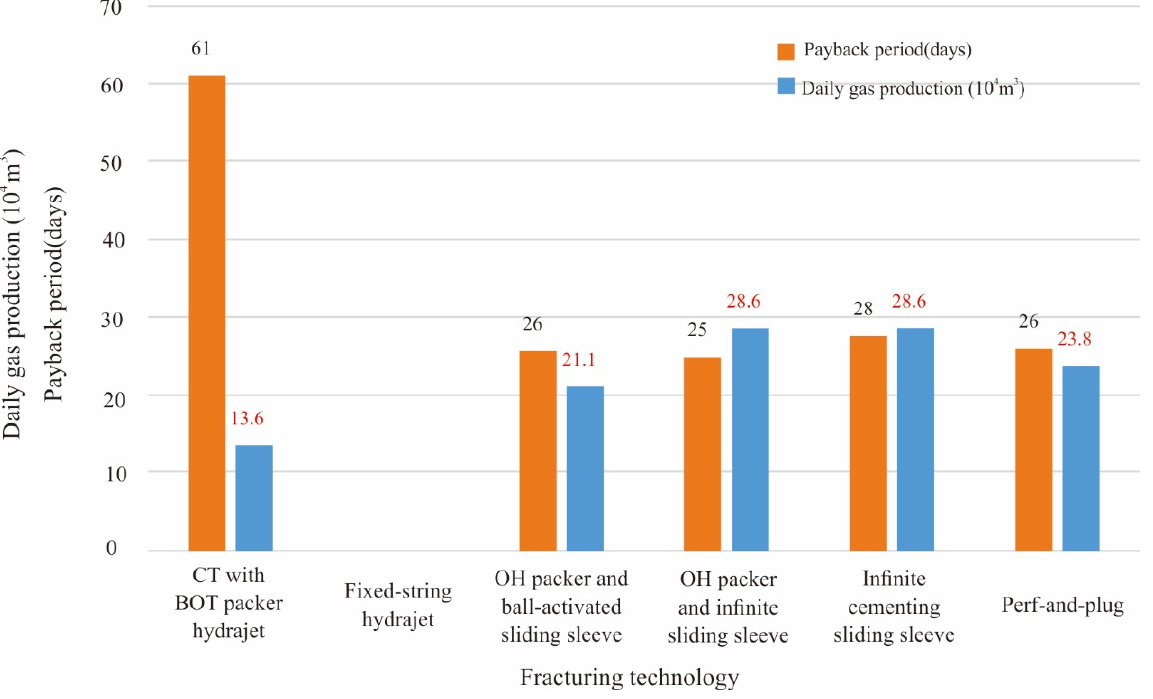
Figure 12. Production and payback period of Class I horizontal wells by multistage fracturing technology.